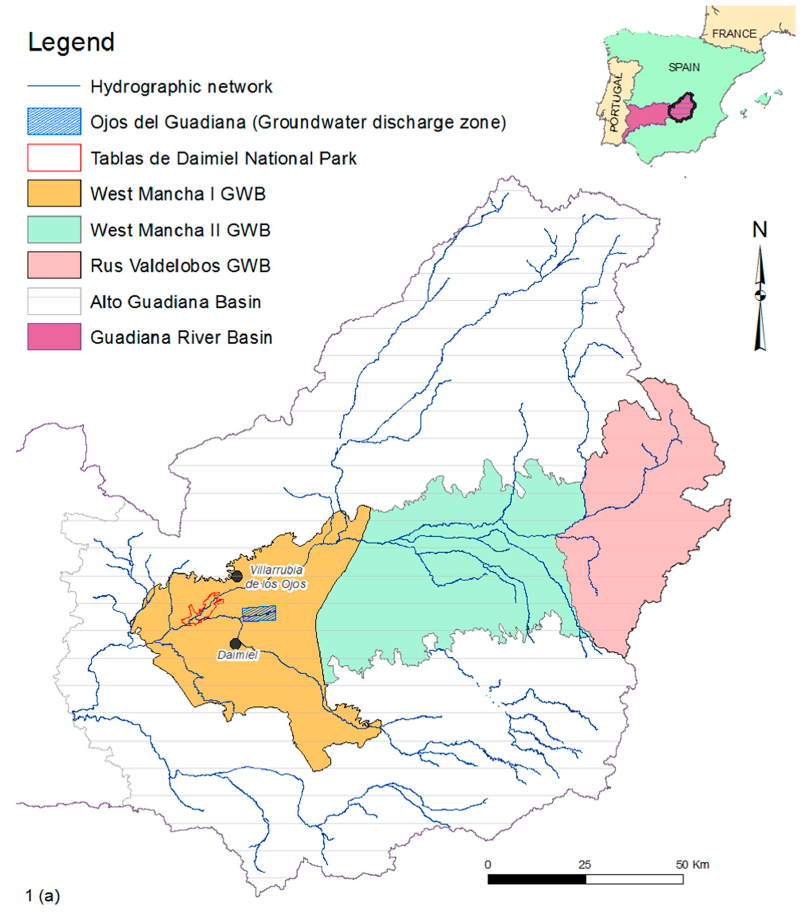
Figure 2. Groundwater bodies of the central area of the Guadiana river high basin.